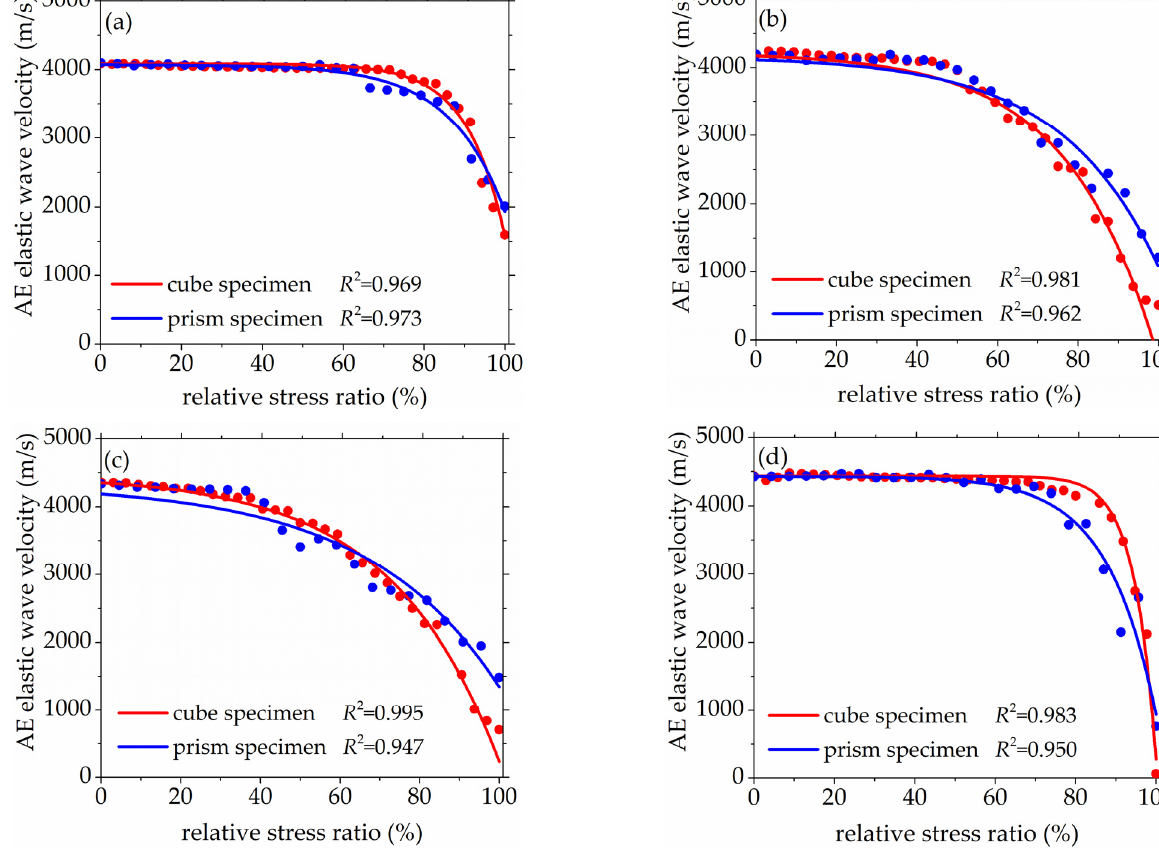
Figure 6. The relationship between AE elastic wave velocity and relative stress ratio with different volume fractions of coarse aggregate, ( a ) 0 %, ( b ) 20 %, ( c ) 40 %, ( d ) 60 %